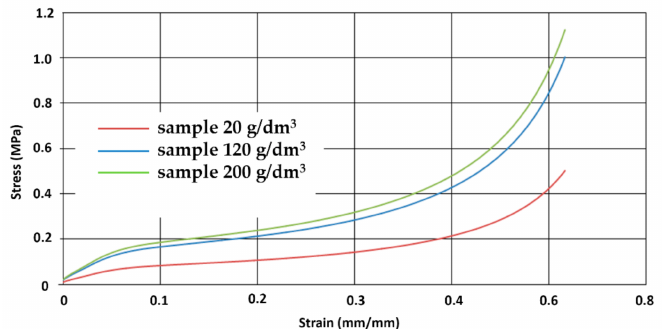
Figure 10. The stress–strain curves of three kinds of EPP foam at a quasi-static loading rate of 2 mm/s.